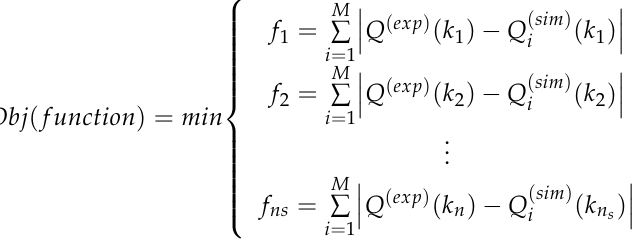
Figure 4. Optimal multi-level particle filter (OPMPF) procedure and remaining useful life (RUL) estimation of Li + battery charge capacity decay.